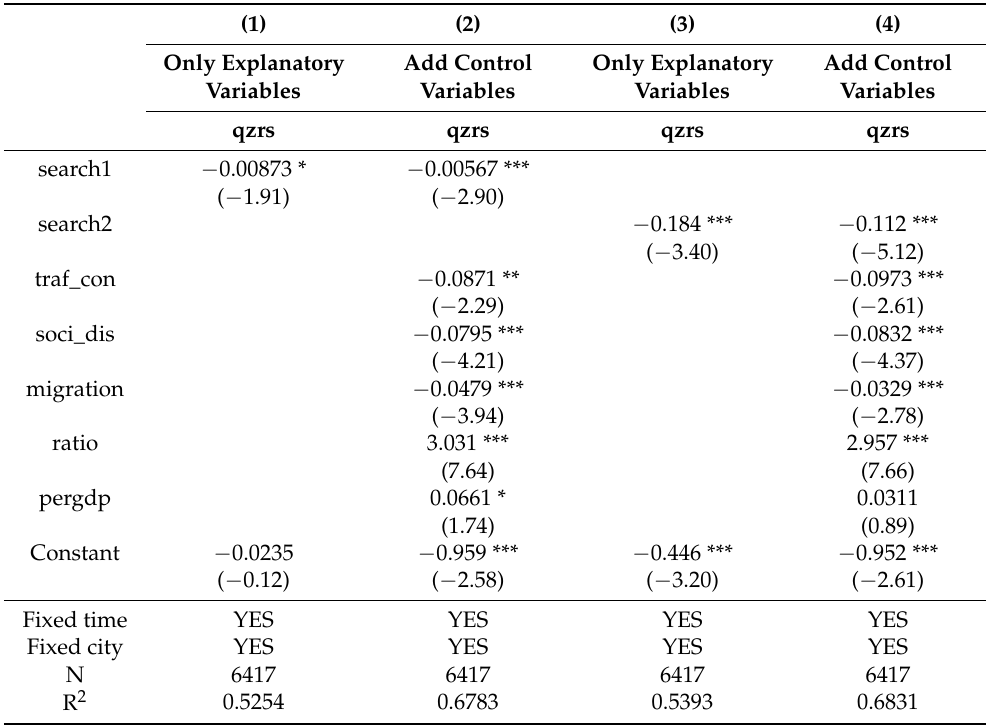
Table 5. Robustness test of information classification.